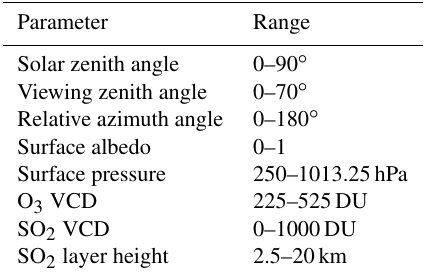
Table 1. Ranges of the eight physical parameters varied in LIDORT- RRS for the synthetic spectra